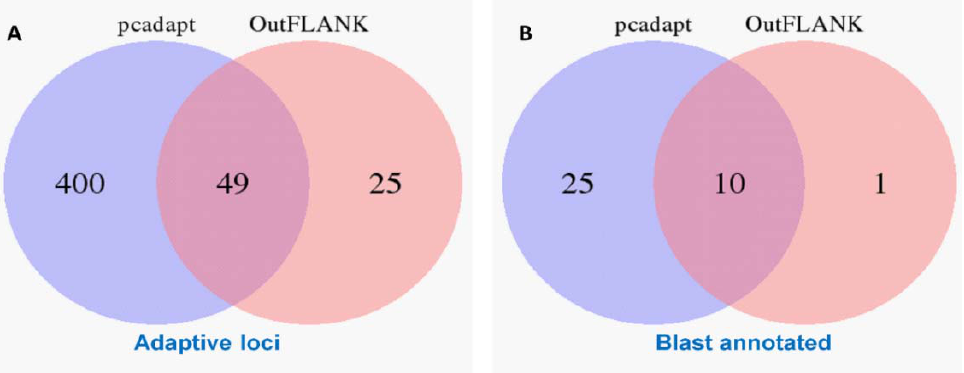
Figure 3. Venn diagram showing the similarity of the putatively adaptive panel of SNP loci ( A ) and a blast annotation of these loci in the coding regions of the known genes ( B ) using the F ST OutFLANK and pcadapt approaches.